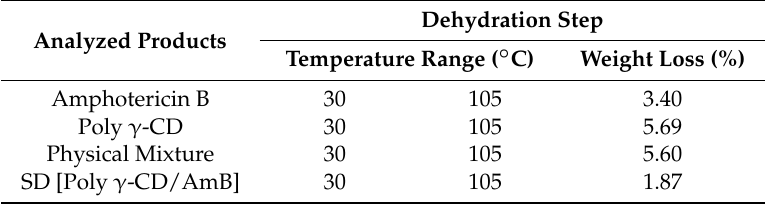
Table 2. Weight loss in percent of amphotericin B (AmB), physical mixture and solid dispersions (SD) based AmB and γ -cyclodextrin polymers (Poly γ -CD) calculated from the dehydration step of thermal analysis.